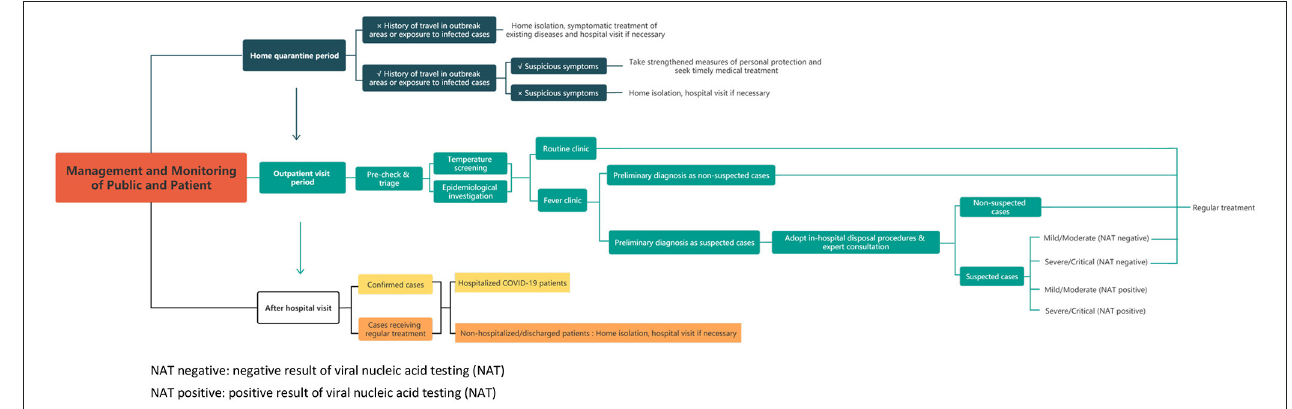
FIGURE 1 | The detailed mode of management and monitoring of public and patient. NAT negative, negative result of viral nucleic acid testing (NAT); NAT positive, positive result of viral nucleic acid testing